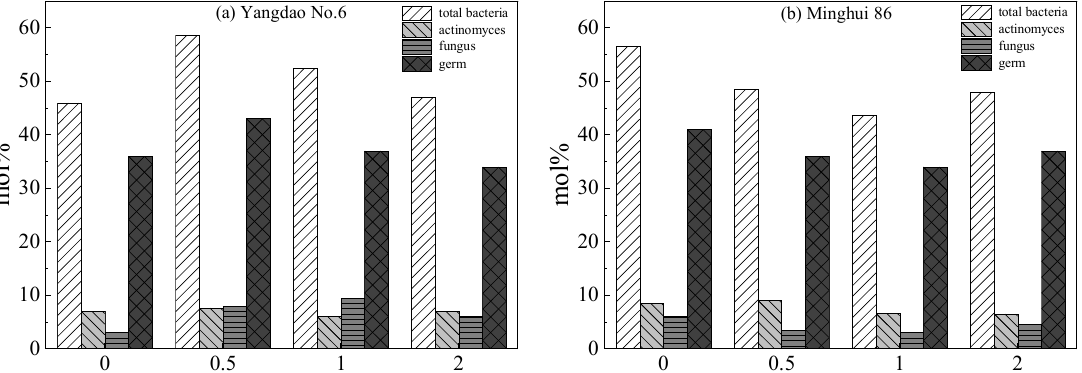
Figure 7. Relative content of rice strains.